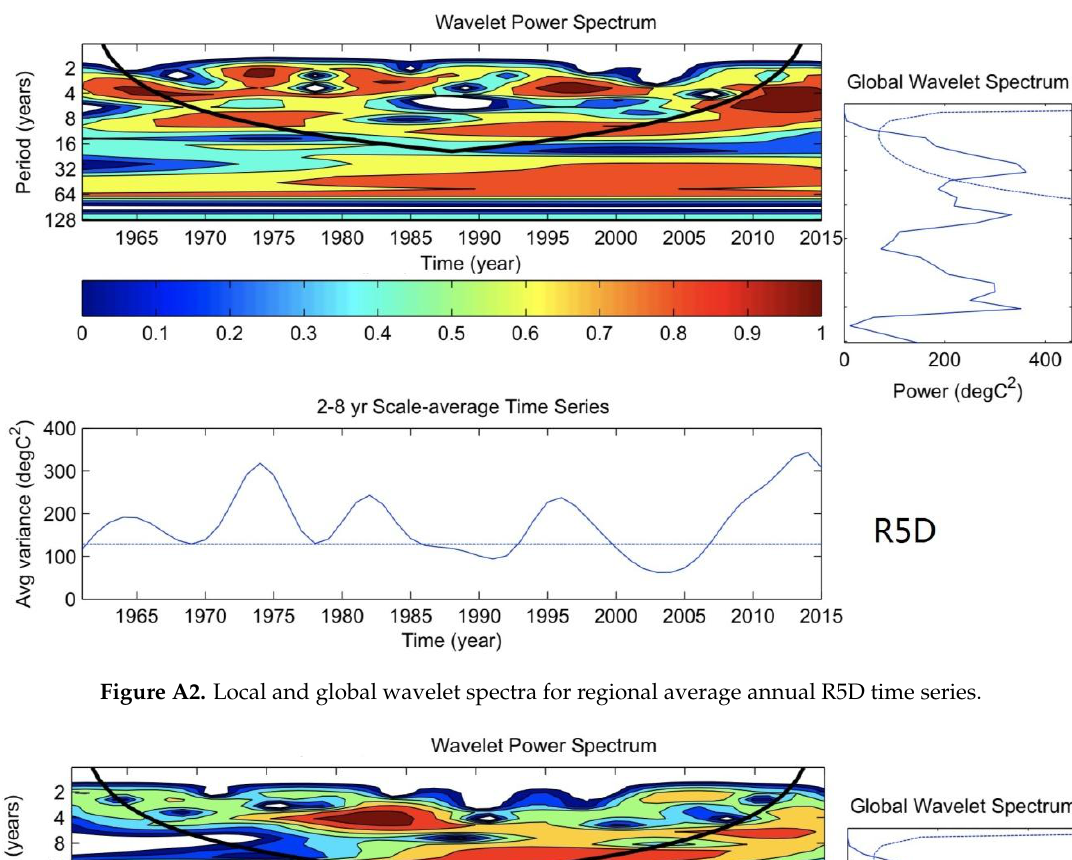
Figure A2. Local and global wavelet spectra for regional average annual R5D time series.